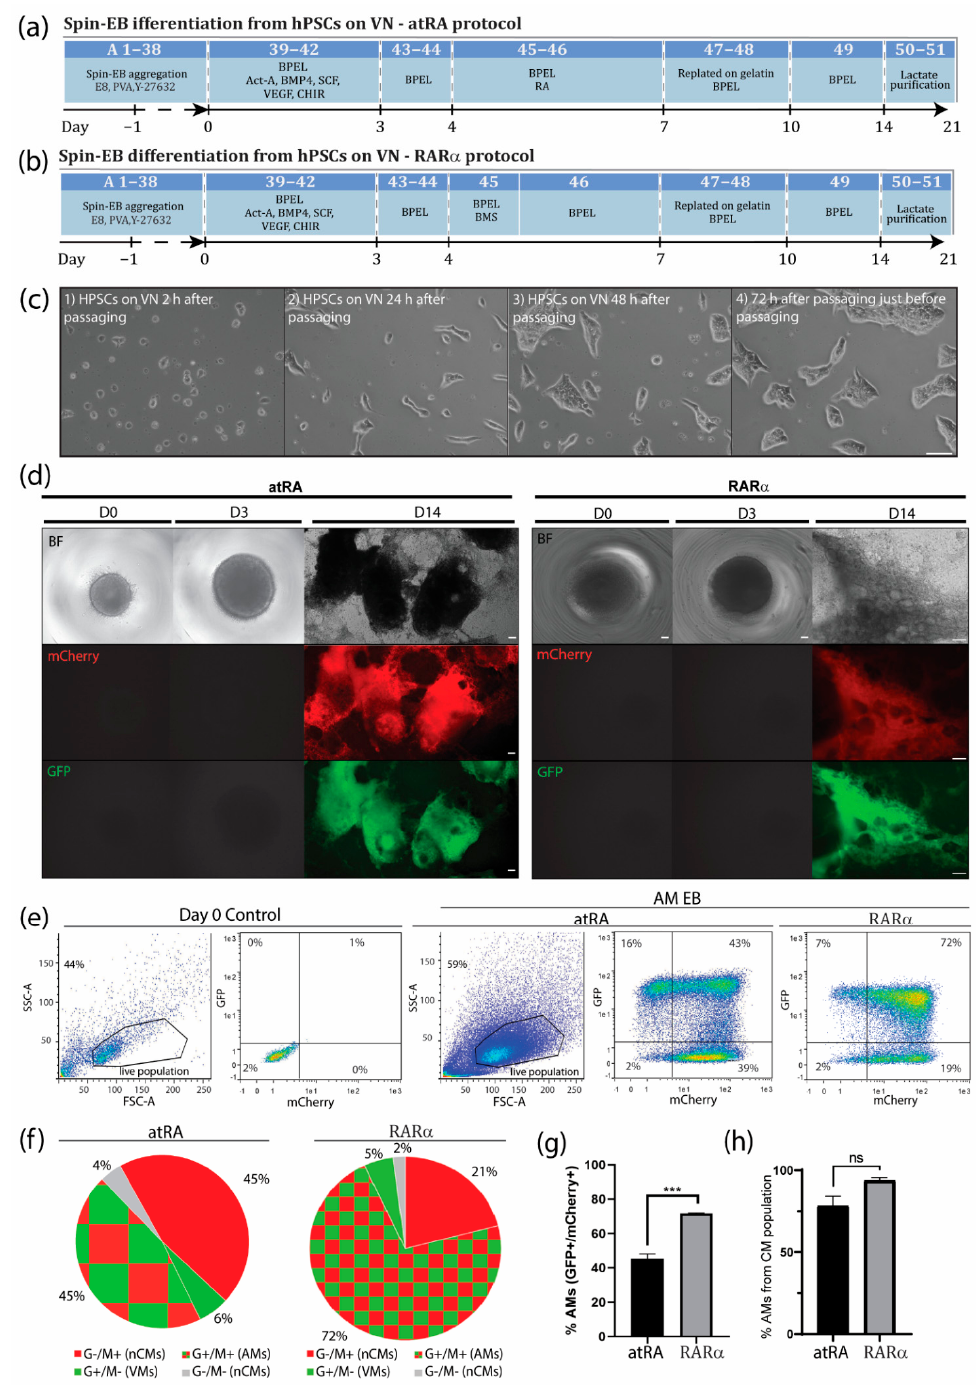
Figure 2. Improved atrial differentiation by activation of retinoic acid receptor (RAR) α . ( a ) Schematic step-by-step representation of atRA-mediated atrial differentiation toward AMs. Numbers correspond to step-by-step procedure in section A from Supplementary Materials. ( b ) Schematic step-by-step representation of RAR α -mediated atrial differentiation toward AMs. Numbers correspond to step-by- step procedure in section A from Supplementary Materials. ( c ) (1) HPSCs cultured in E8 medium on VN 3 h after passage and (2) 24 h, (3) 48 h, and (4) 72 h after passage and just before the next passage. Scale bar = 100 µ m. ( d ) Spin EBs from hPSCs grown in E8 on VN at days 0, 3, and 14 of differentiation with atRA (left panel) or optimized atrial protocol with RAR α (right panel). Endogenous COUP-TFII- mCherry expression together with endogenous NKX2.5-GFP and bright-field (BF) images in AM and VM differentiations. Scale bar = 100 µ m. ( e ) Representative flow cytometry plots depicting